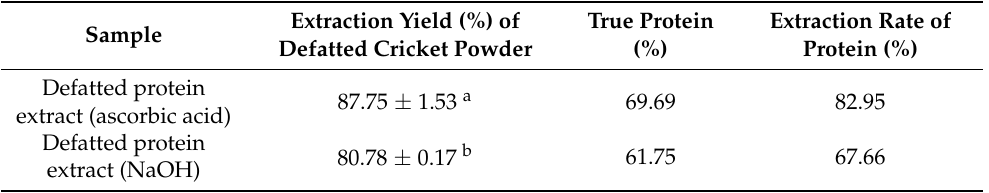
Figure 9. Protein solubility (%) with changes at pH 2–11. Tenebrio molitor (square), Gryllodes sigillatus (triangle), and Schistocerca gregoria (circle) [27]. (triangle), and Schistocerca gregoria (circle) [27]. Table 4. Extraction yield, true protein content, and extraction rate of protein from ethanol defatted cricket powder